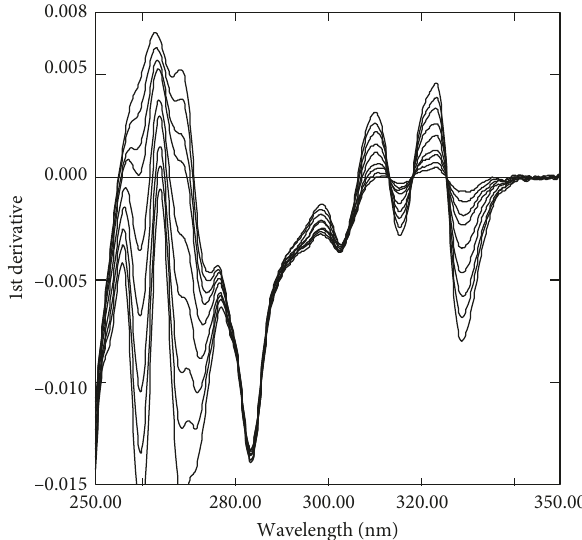
Figure 6: First derivative spectra of mixture containing 0.5, 1, 1.5, 2, 3, 4, 5, 6, and 7 μ g · mL − 1 chlorothalonil and 10.0 μ g · mL − 1 pyriproxyfen.